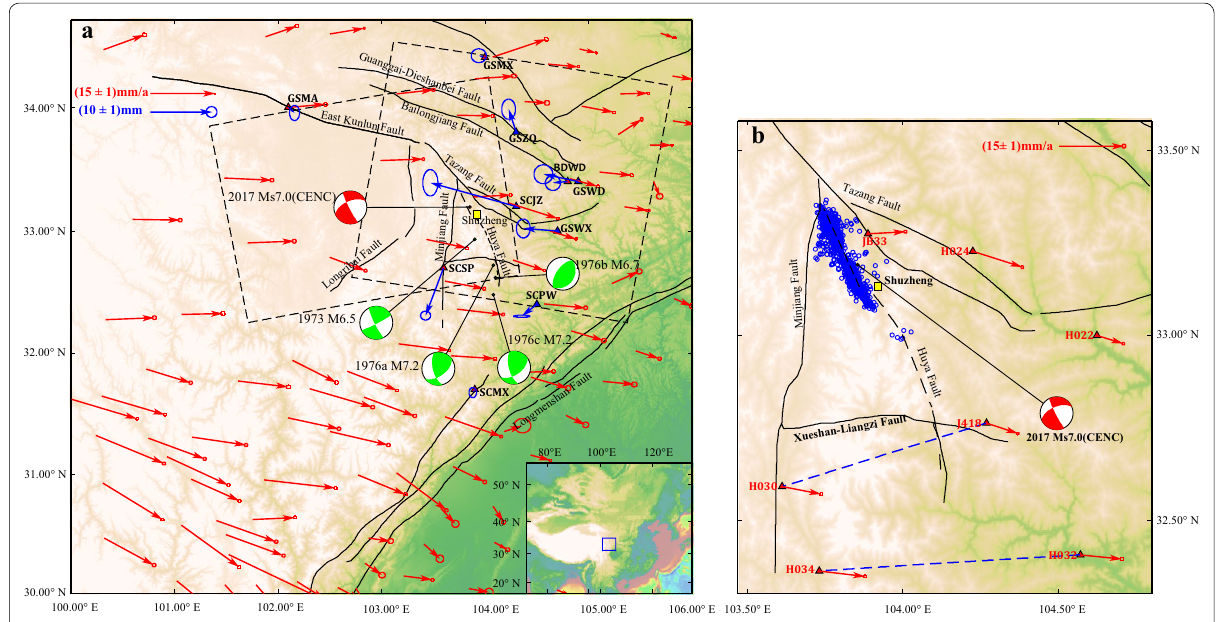
Fig. 1 a Topography, faults, GPS velocity field with 95% confidence ellipses relative to the Eurasian Plate, coseismic horizontal GPS deformation and Sentinel‑1A SAR image range in the epicenter and the surrounding area of the Jiuzhaigou earthquake. The black curved lines represent faults. The black dashed quadrilaterals represent the area covered by the descending and ascending Sentinel‑1A images. The red triangles represent continu‑ ous GPS stations of the Crustal Movement Observation Network of China and the blue triangles the Beidou Ground Based Augmentation System stations. The red arrows represent the horizontal velocity field before the earthquake, and the blue arrows represent the coseismic deformation of the horizontal component. b Aftershock distribution, tectonic setting, and GPS velocity with 95% confidence ellipses relative to the Eurasian